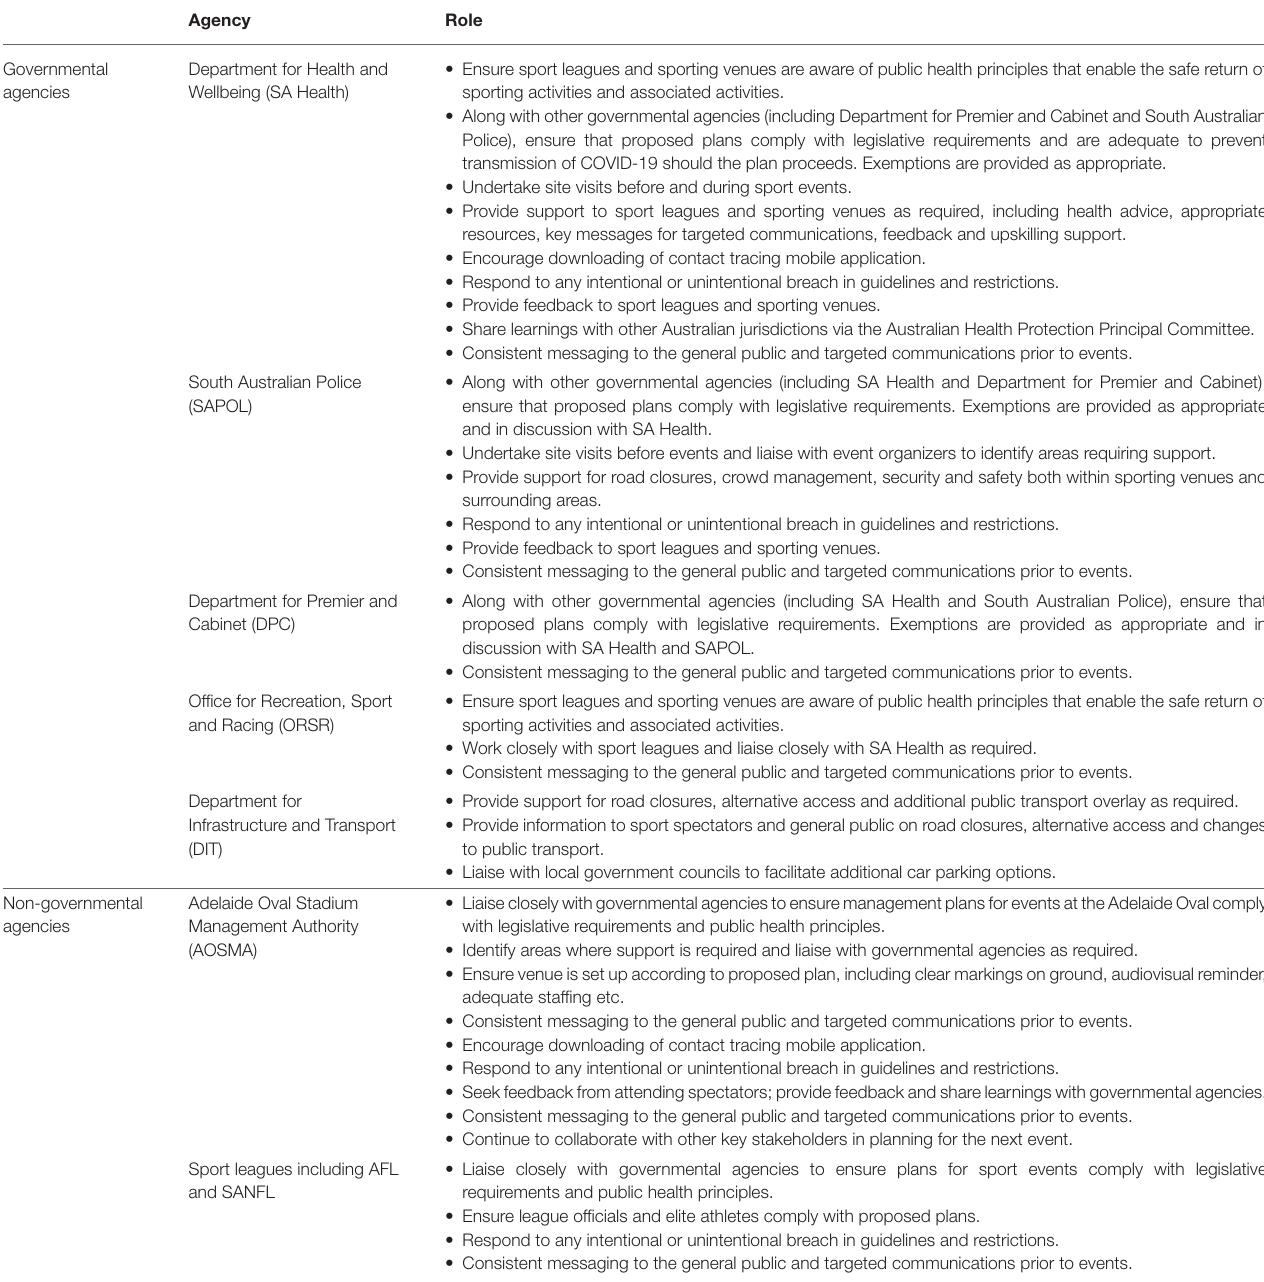
TABLE 1 | Key stakeholders and their roles in the reopening of Adelaide Oval and recommencement of sport leagues in South Australia.